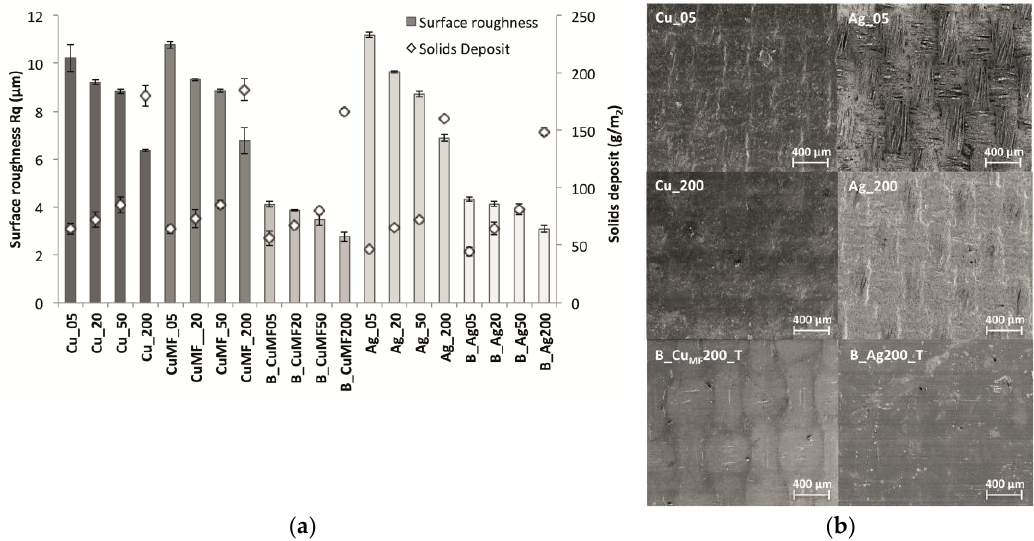
formulation and gap height. Individual standard deviations were used to calculate the intervals, and the plot displays a 95% confidence interval (CI) for the mean. ( b ) Scanning electron microscopy (SEM) images of samples coated with the Cu and Ag formulations showing the mass per unit area in brackets Cu_05 (64 g/m 2 ), Cu_200 (180 g/m 2 ), B_Cu MF 200_T (166 g/m 2 ), Ag_05 (47 g/m 2 ), Ag_200 (160 g/m 2 ) and B_Ag200_T (149 g/m 2